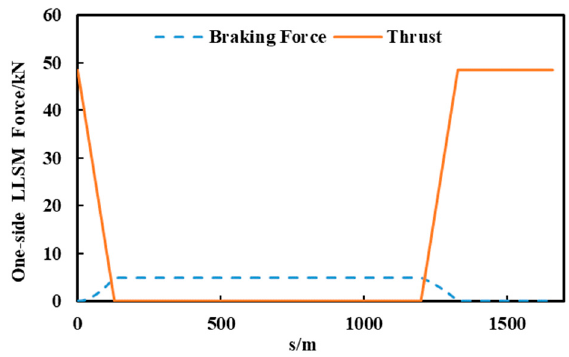
Figure 6. The force of one-side LLSM during the process.